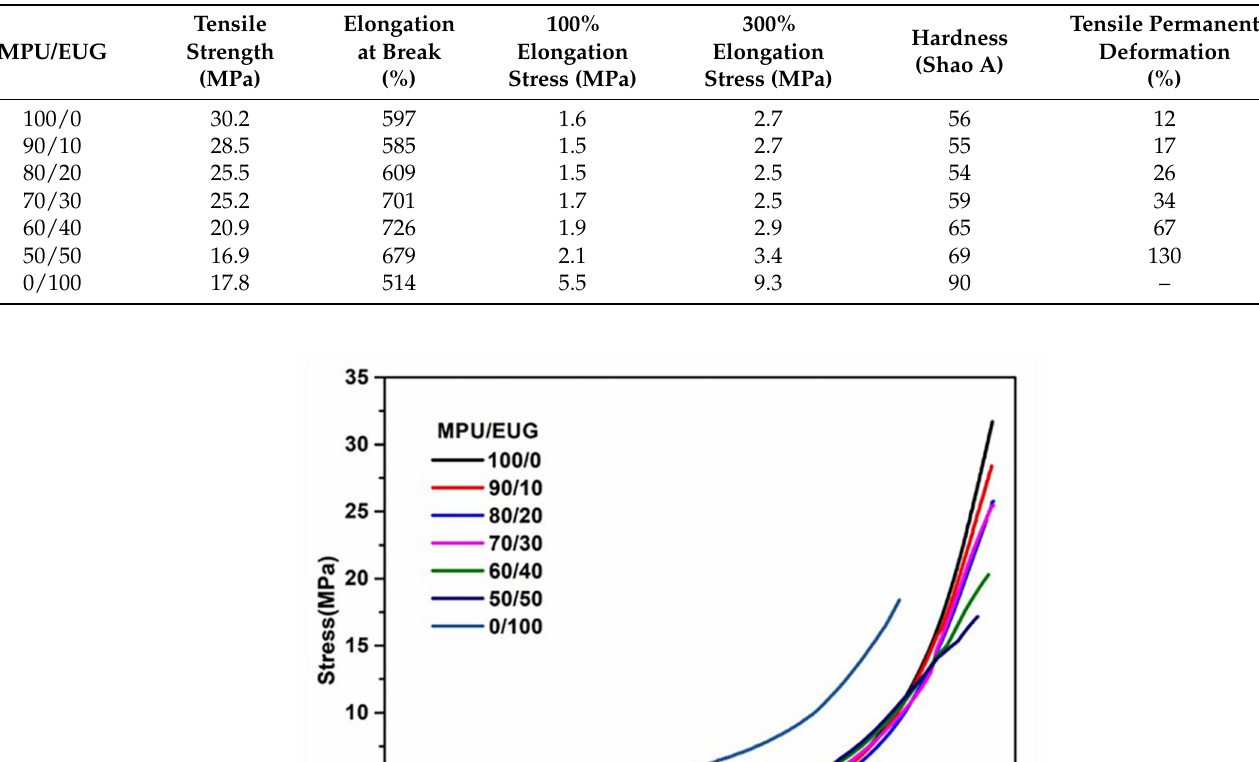
Table 3. Mechanical properties of various MPU/EUG composites.